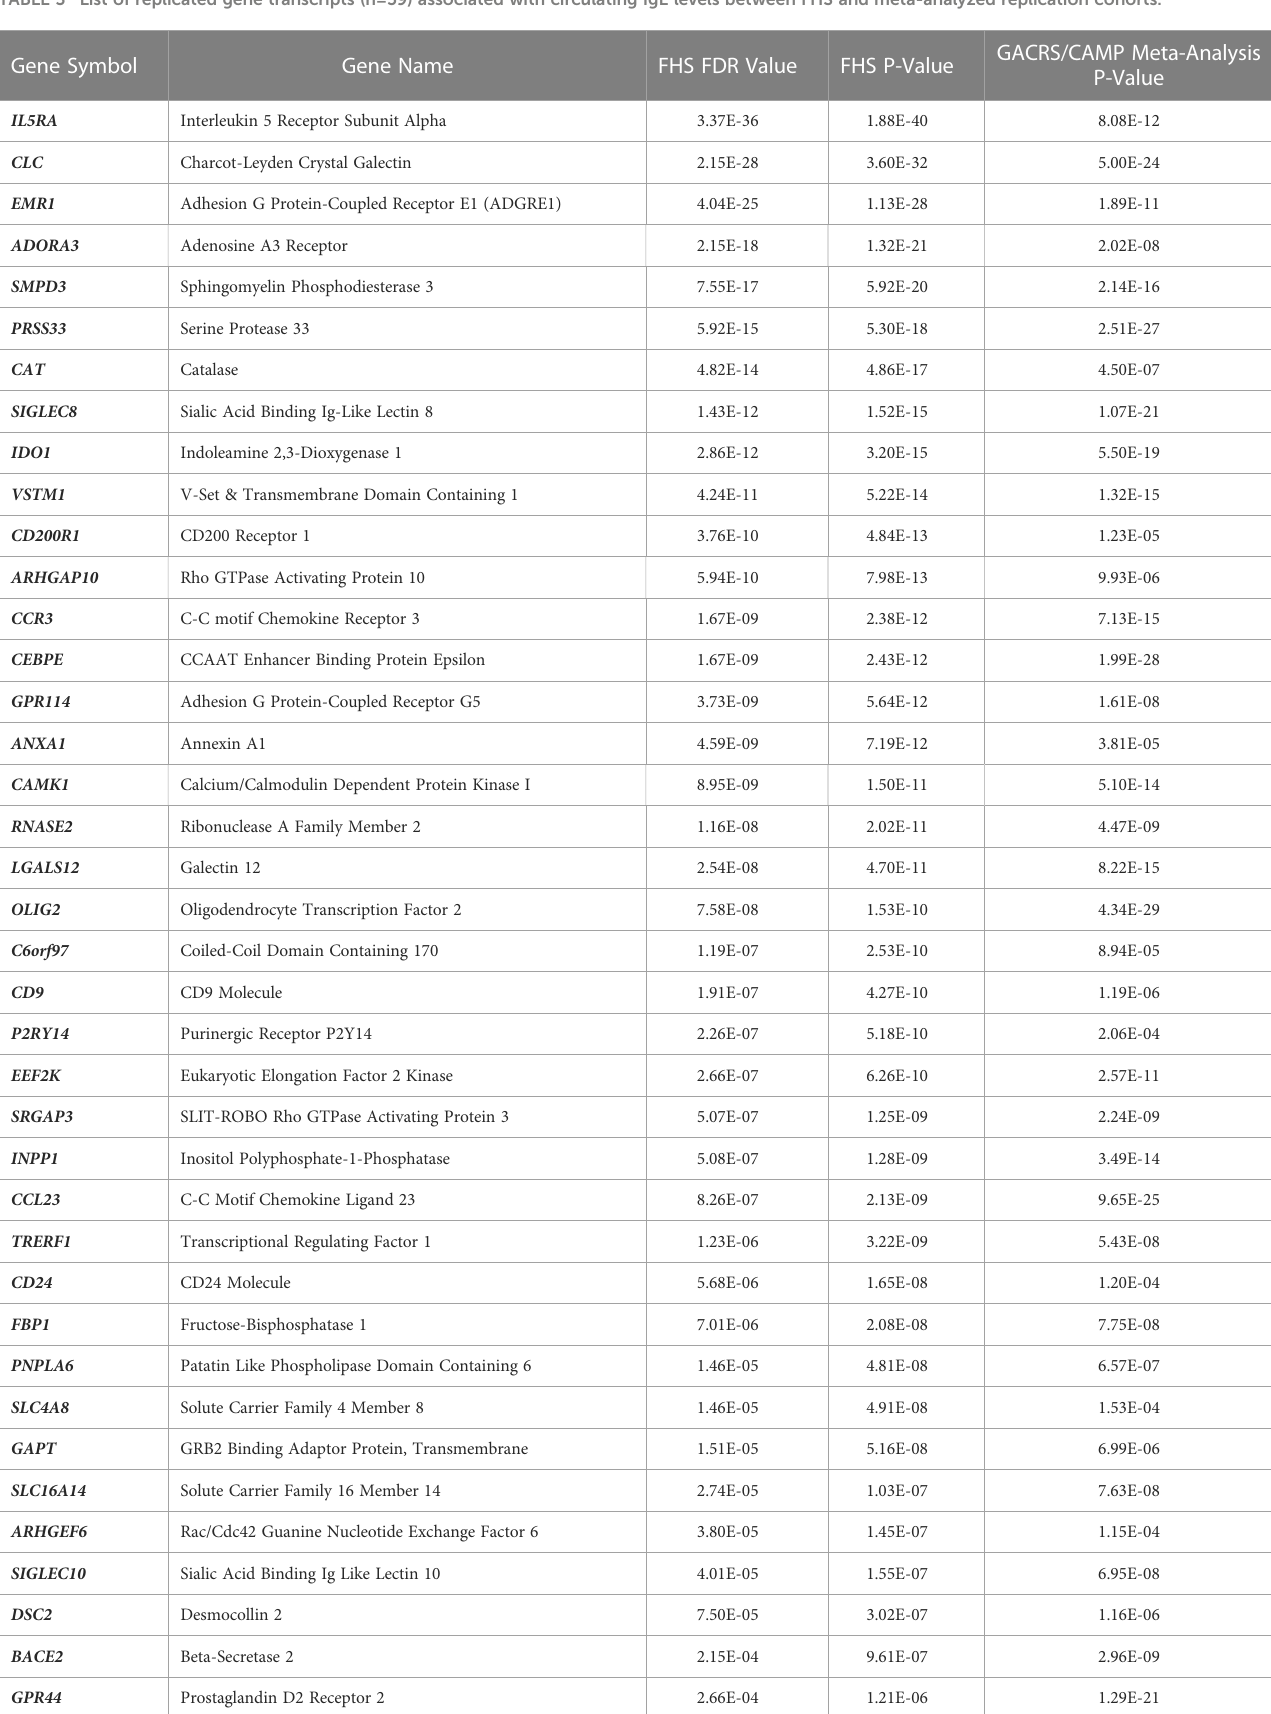
TABLE 3 List of replicated gene transcripts (n=59) associated with circulating IgE levels between FHS and meta-analyzed replication cohorts.